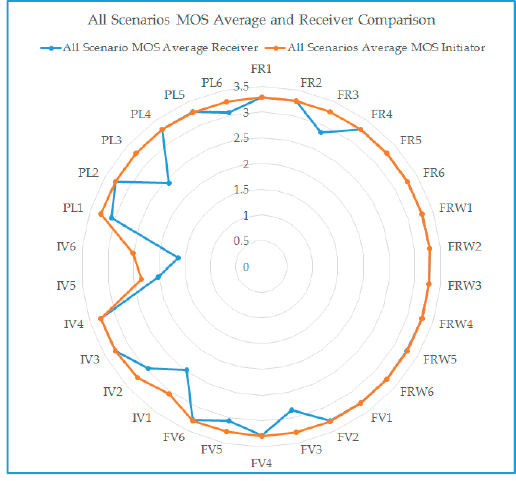
Figure 19. MOS values average comparison for VoIP initiators and receivers.